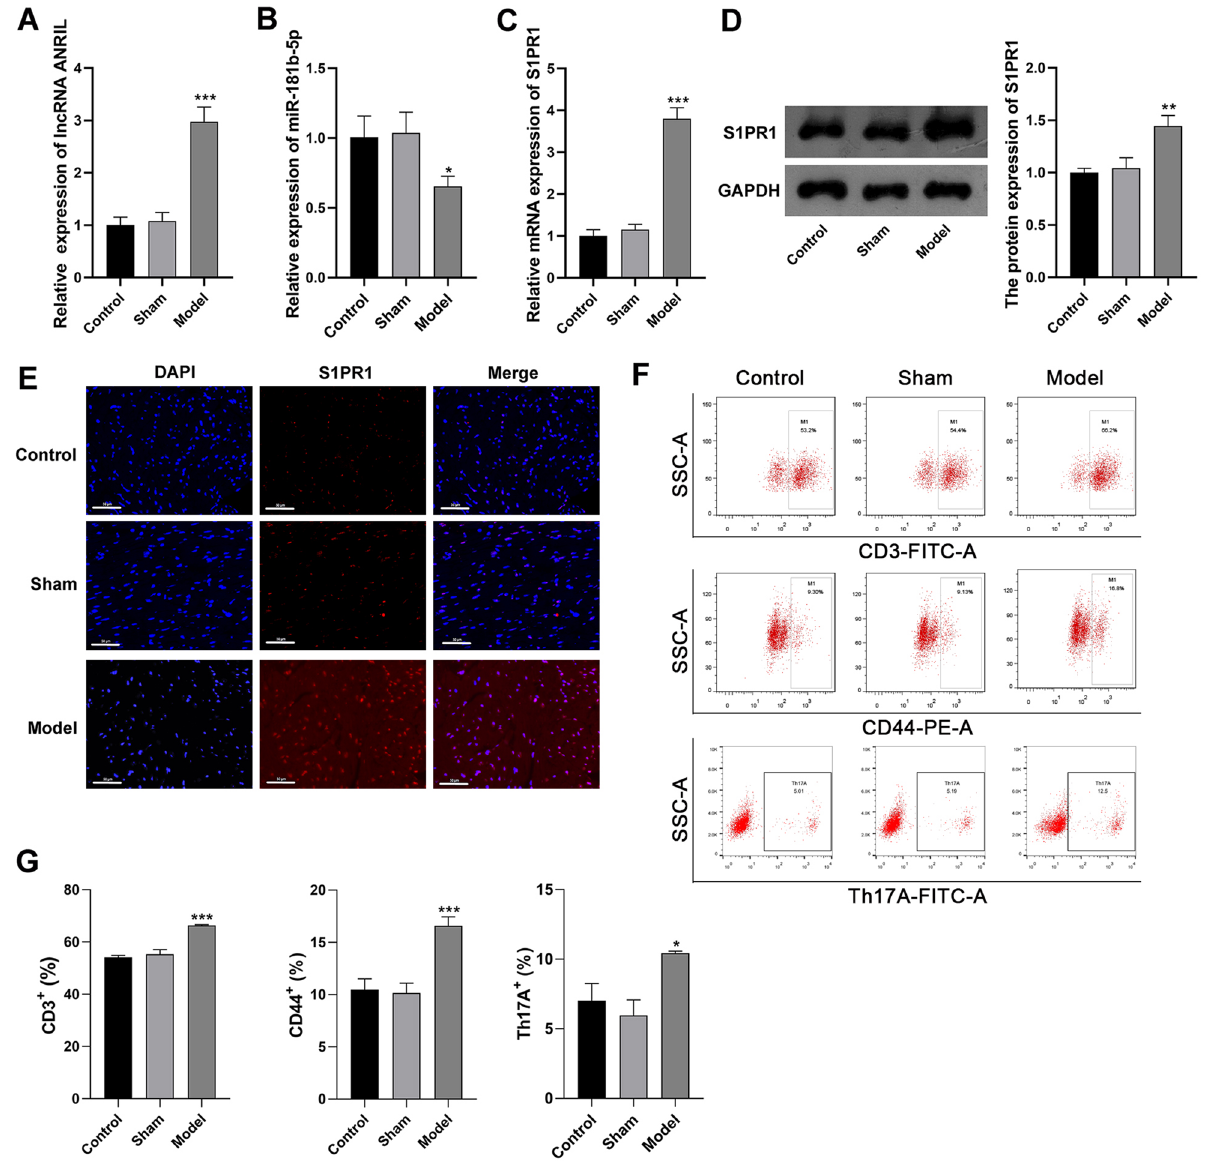
Figure 2. ANRIL/miR-181b-5p/S1PR1 expression and T cell activation in myocardial tissues of UC mice ( A ) qRT-PCR of ANRIL expression; ( B ) qRT-PCR of miR-181b-5p expression; ( C ) qRT-PCR of S1PR1 mRNA expression; ( D ) Western blot of S1PR1 protein expression; ( E ) immunofluorescence of S1PR1 expression, scale bar = 50 μm; ( F ) flow cytometry of T cell markers (CD3, CD44, and Th17A); ( G ) quantifying of cells positive for CD3, CD44, and Th17A. *P < 0.05, **P < 0.01, ***P < 0.001 vs. control. Data was analyzed using one-way analysis of variance (ANOVA) followed by Tukey’s plasma level of lncRNA DKFZP434I0714 was increased in uremic patients, presenting an independent predictor of poor cardiovascular outcome 25 . Wang et al. have found that lncRNA ZFAS1 promotes cardiac fibrosis in mice